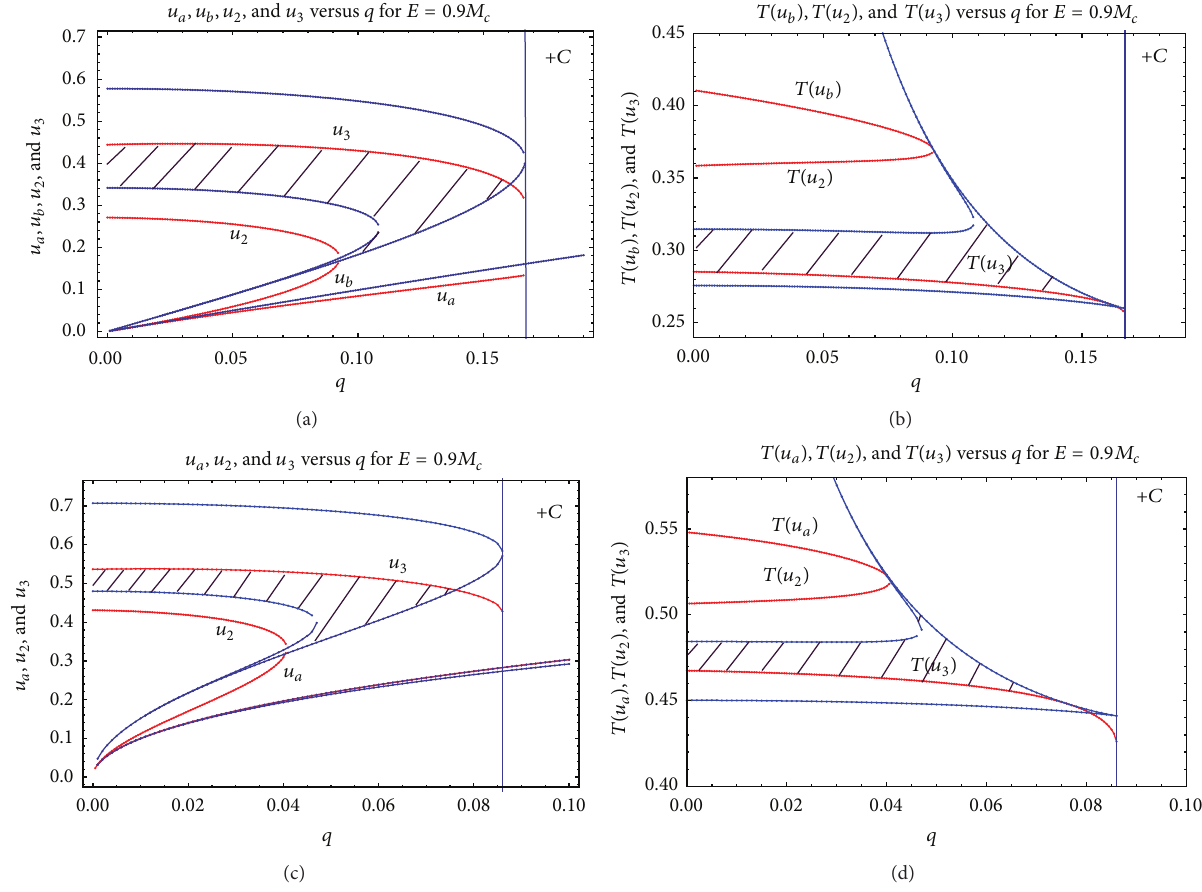
Figure 8: The energy condition 𝐸 < 0.9𝑀 𝑐 overlapping with the heat capacity condition for the fixed charge case. Allowed region is the shade area. In (a) and (b): 𝑢 𝑎 , 𝑢 𝑏 , 𝑢 2 , and 𝑢 3 and the corresponding temperatures versus the bulk charge 𝑞 for AdS 4 . In (c) and (d): 𝑢 𝑎 , 𝑢 2 , and 𝑢 3 and the corresponding temperatures versus the bulk charge 𝑞 for AdS 5 . For all plots, we set 𝑔 𝑏 = 𝑔 𝑓 = 2